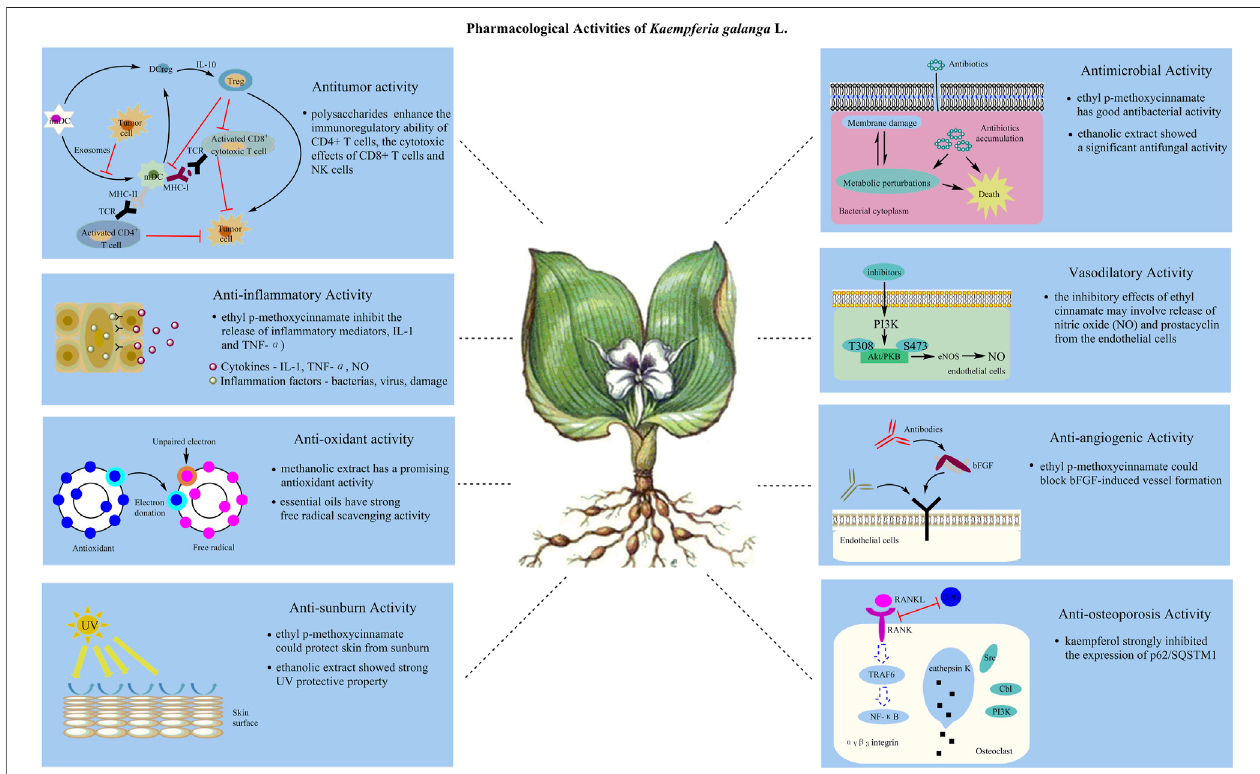
FIGURE 1 | Primary reactions and constituents supporting various biological effects of K. galanga . The TCHM shows antitumor, anti-in fl ammatory, anti-oxidant, anti-sunburn, antimicrobial, vasodilatory, anti-angiogenic and anti-osteoporosis activities, et al. Multiple types of constituents (see Table 3 ) are contributed to such evident pharmacological pro fi les of this